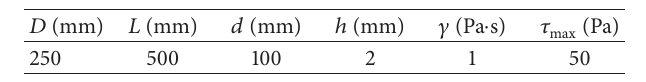
Table 3: Parameters of MRD.